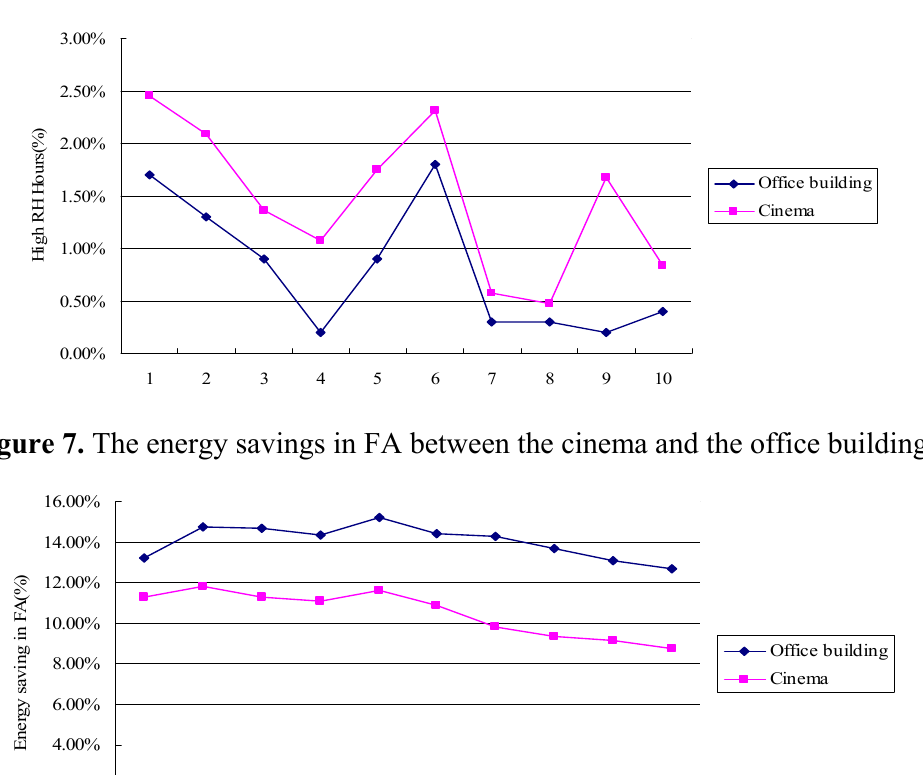
Figure 6. The percent of high RH hours between a cinema and an office building.